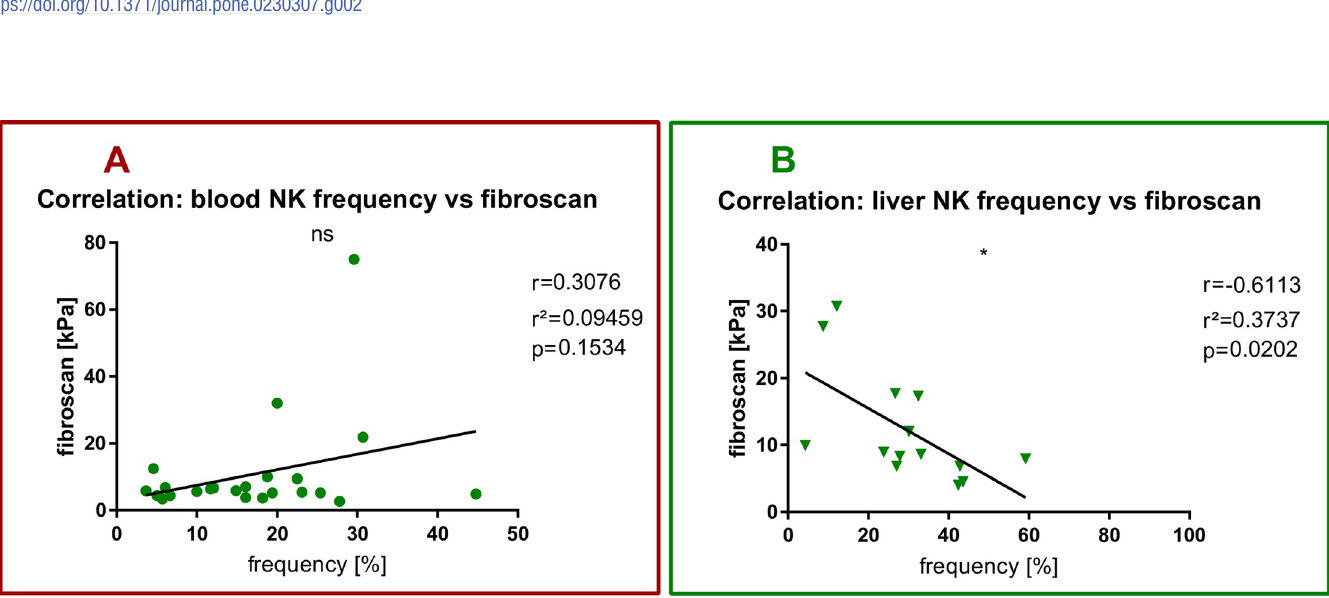
Fig 3. NK cells and hepatic fibrosis in NAFLD. Each spot represents one patient. (A) PBMC data. (B) intrahepatic data. (A) Pearson’s correlation between peripheral NK cell frequency and fibroscan with Pearsons r, r 2 and p value. (B) Pearson’s correlation between intrahepatic NK cell frequency and fibroscan with Pearsons r, r 2 and p value. � p < 0.05, �� p > 0.01.